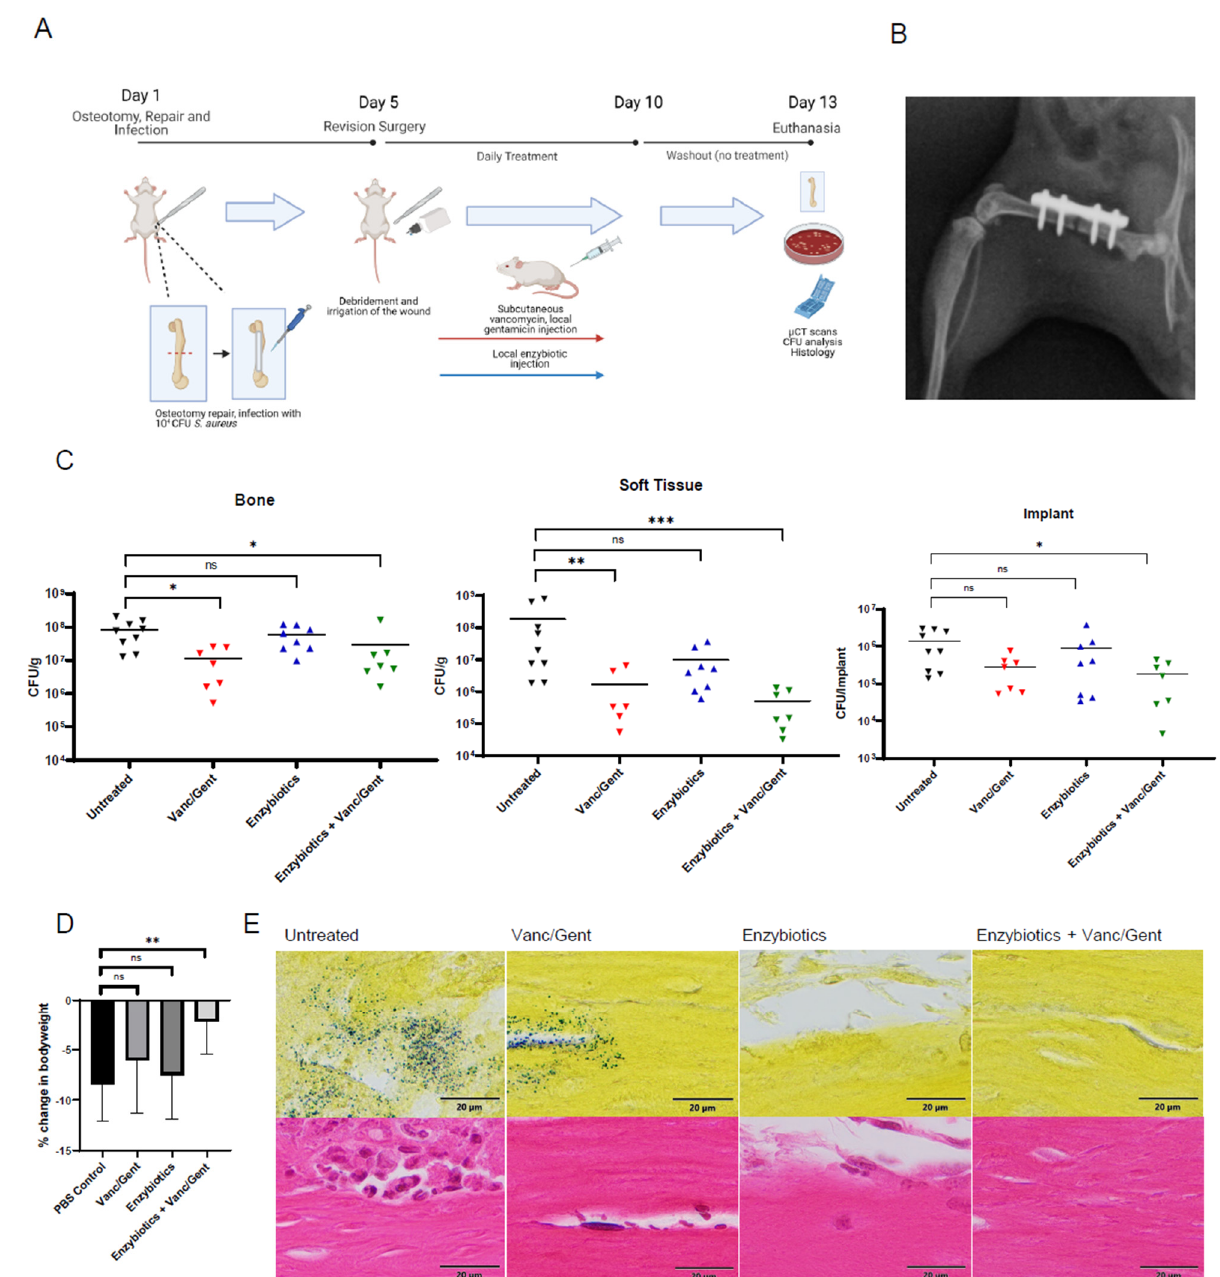
Figure 5. Enzybiotics are effective at treating MRSA fracture-related infection in combination with antibiotics in vivo. ( A ) An overview of the mouse model of fracture-related infection. On day 1, mice receive an osteotomy in the right femur, which is repaired with a 4-hole titanium plate. 10 4 CFU of S. aureus USA300 is added directly on top of the plate before the wound is sutured closed. The infection is allowed to mature for 5 days before revision surgery is performed and initial treatment (antibiotics, enzybiotics, or both) is administered. Daily treatment proceeds for the subsequent five days before being halted for a three-day washout period. Mice are euthanized on day 13, and CFU counts of the femur, implant, and surrounding soft tissue are analyzed. ( B ) An example radiograph image of a mouse hindleg after receiving an osteotomy and repair surgery. ( C ) CFU counts from the homogenized femur (bone), surrounding soft tissue, and implant from mice receiving the indicated treatments. ( D ) Percent change in body weight from the time of initial surgery (day 0) to the time of euthanasia (day 13). ( E ) Representative Brown and Brenn (upper; SA in blue) and Hematoxylin and Eosin (lower) stains of mouse soft tissue sections adjacent to the osteotomy. The two stains were performed on adjacent histological sections from the same mouse receiving the indicated treatment regimen. * p ≤ 0.05, ** p ≤ 0.01, *** p ≤ 0.001, ns: p > 0.05.